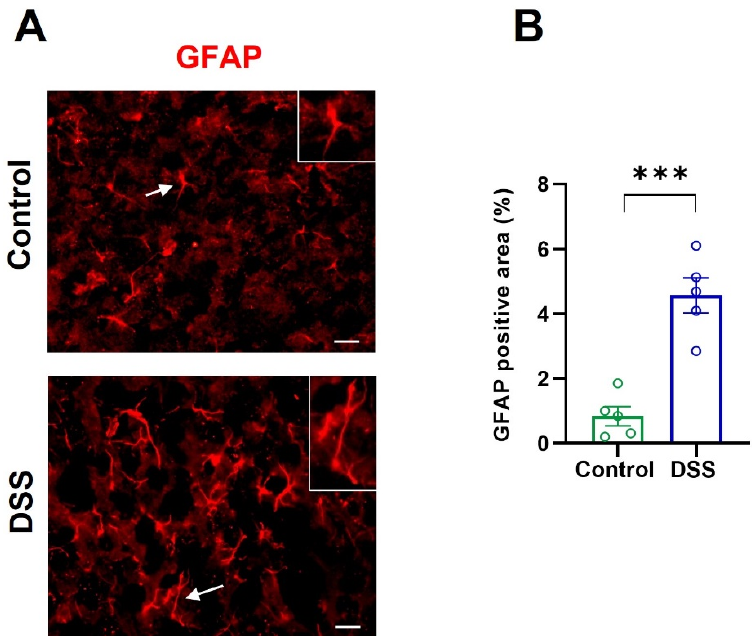
Figure 3. Astrocyte activation in the motor cortex of control and DSS-treated rats. ( A ) Immunofluo- rescence of GFAP was performed in brain sections containing primary motor cortex. The cells pointed to by arrows are shown in higher magnification. Scale bar represents 20 µ m. ( B ) Quantification of GFAP immunostaining area expressed as percentage of the analyzed area in the primary motor cortex. The number of animals was 5 for each group and the number of measurements in each animal was 30–50 ( n = 5 animals per group). Data are means ± SEM. Student’s t -test: *** p < 0.001, DSS-treated rats vs.